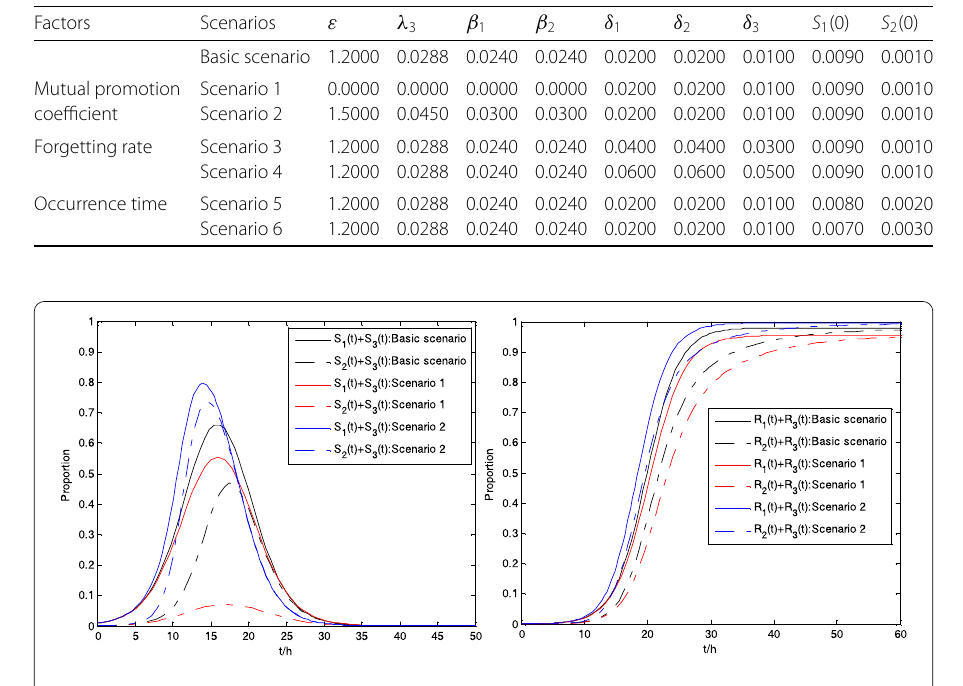
Figure 6 Proportion of spreaders and stiflers over time in different mutual